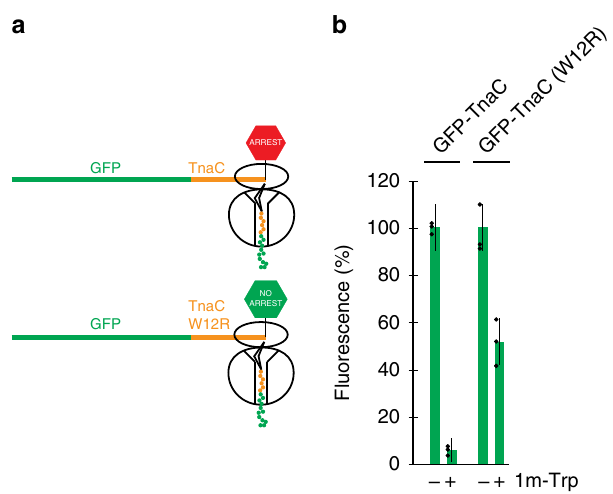
Fig. 6 Engineering the reporter for selecting gain-of-function rRNA mutations. a Appending the TnaC-coding sequence to the end of gfp is expected to reduce the reporter expression due to the inhibitory action of TnaC on termination when translation occurs at high concentrations of L - tryptophan 28 . The presence of the W12R mutation in TnaC is known to partially alleviate the termination problem 28 and should lead to a higher level of reporter expression. b Expression of the GFP-TnaC fusion in the OSYRIS cells is inhibited by 94% in the presence of the L -tryptophan analog 1-methyl tryptophan (1m-Trp), while the expression of the GFP-TnaC (W12R) mutant decreases only by 48%. The graph bars represent mean ± s.d. of three technical replicates. The raw data can be found in the Source data fi